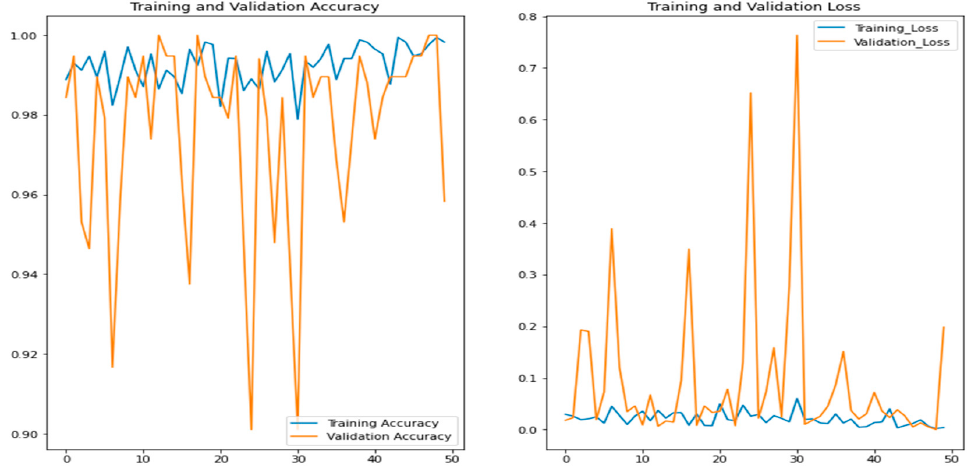
Figure 5. Graph of training and validation accuracy vs. loss for the proposed model.